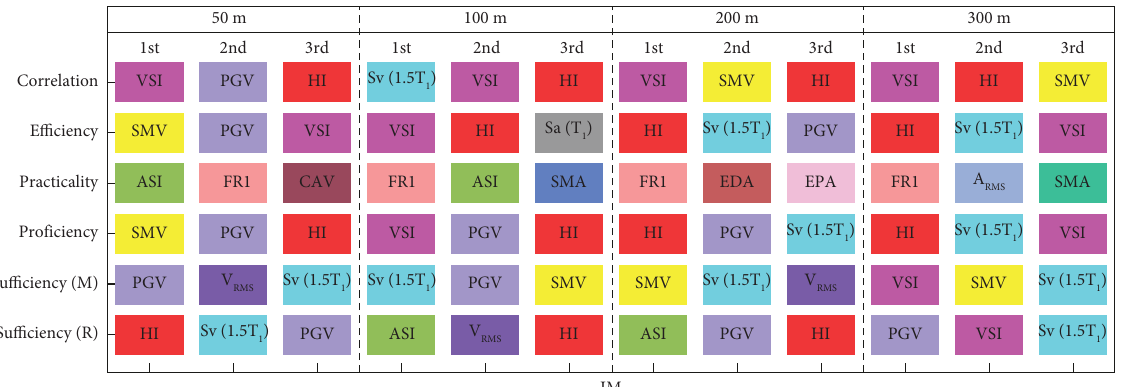
Figure 15: Top 3 correlated, efcient, practicable, profcient, and sufcient IMs for the slopes with diferent mining